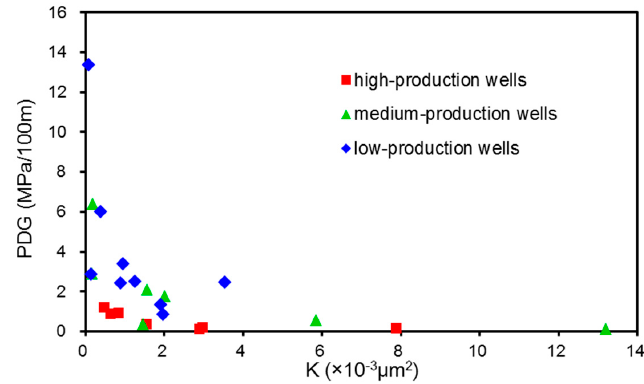
Figure 10. The relation between PDG and permeability in water drainage stage.